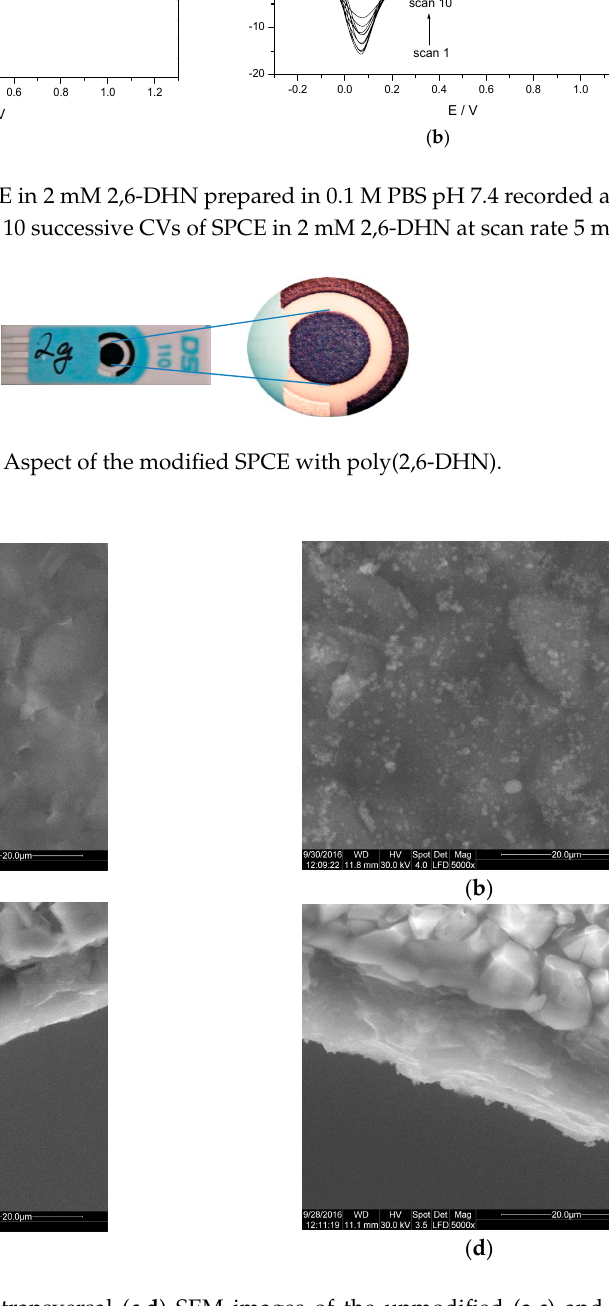
Figure 3. Frontal ( a , b ) and transversal ( c , d ) SEM images of the unmodified ( a , c ) and modified ( b , d ) SPCE.